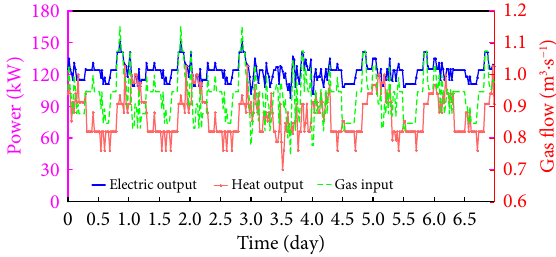
Fig. 11 The generated operating characteristics of